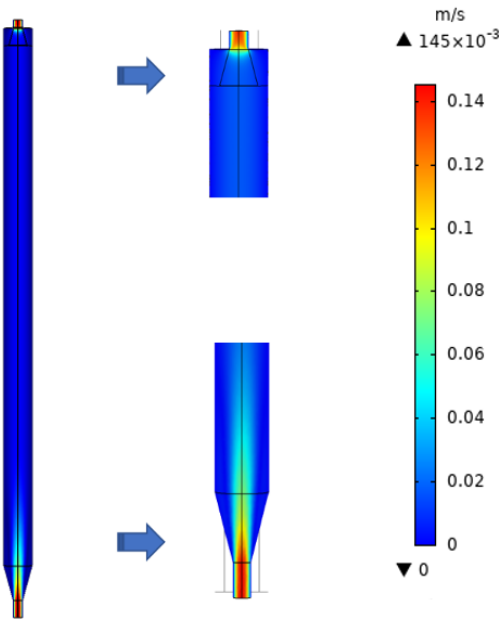
Figure 2. CFD simulation results of the velocity distribution in the PFA